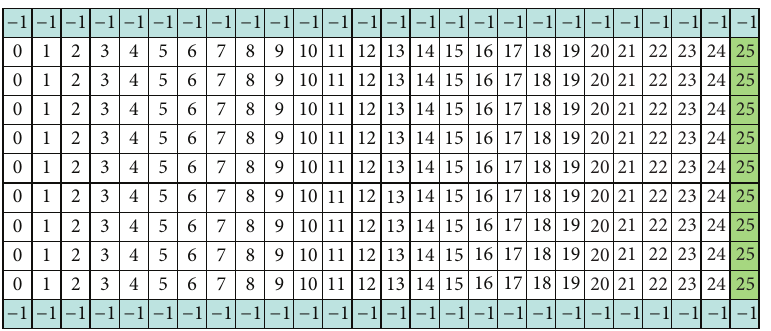
Figure 4: Static floor field 𝑆 for the walkway of size 𝑊 × 𝐿 with exit cells on the right side.